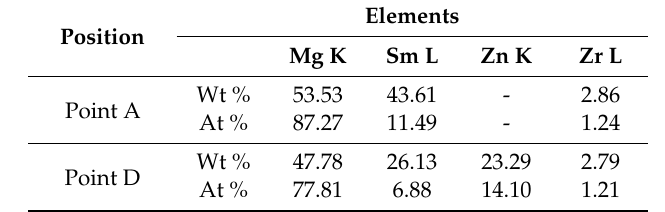
Table 2. The chemical compositions of second phases in Figure 2a,d analyzed by EDS.